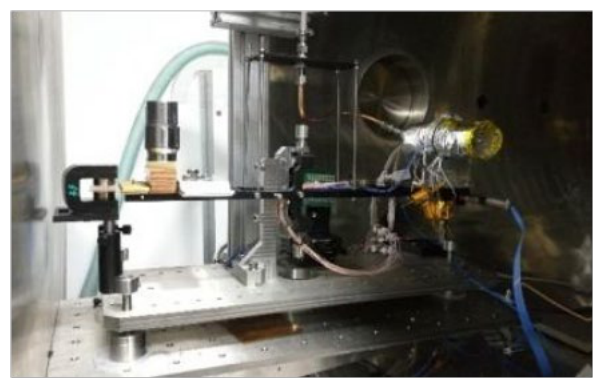
Figure 6. Establishment of thrust measurement system.